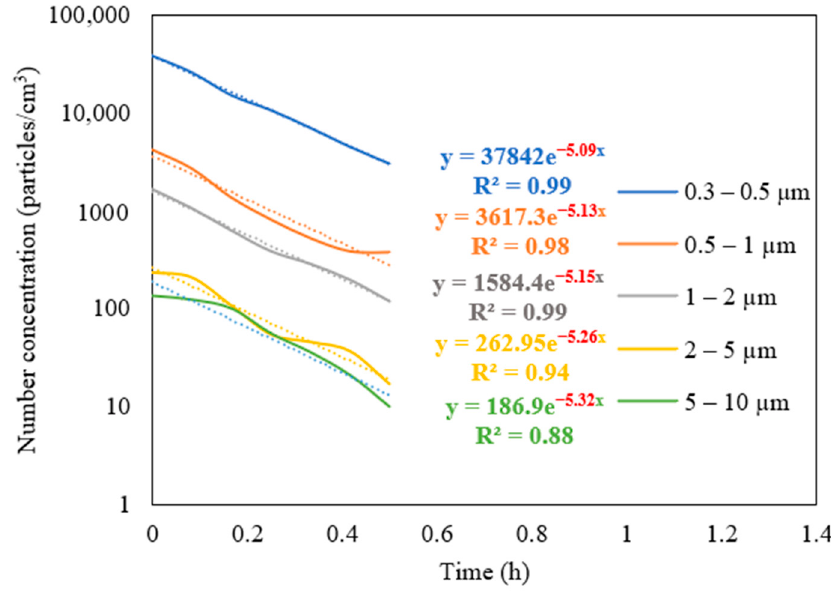
Figure 6. Decay rate curves as a function of particle size in classroom 3 after switching off the NaCl source and operating the purifier at a flow rate of 267 m 3 /h. The dotted curves represent exponential trendlines.